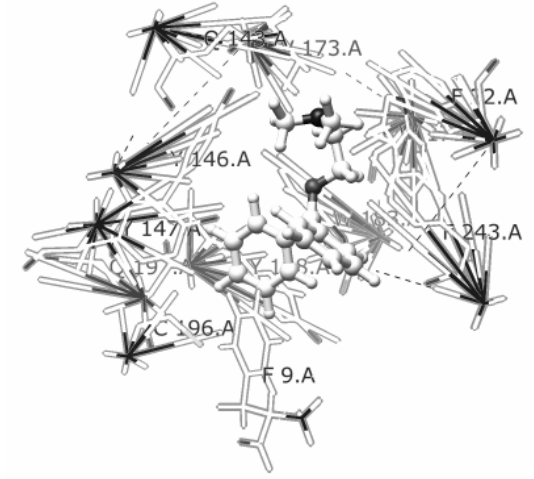
Figure 3. Active site of HMT with diphenhydramine. (Hydrogen atoms are suppressed for